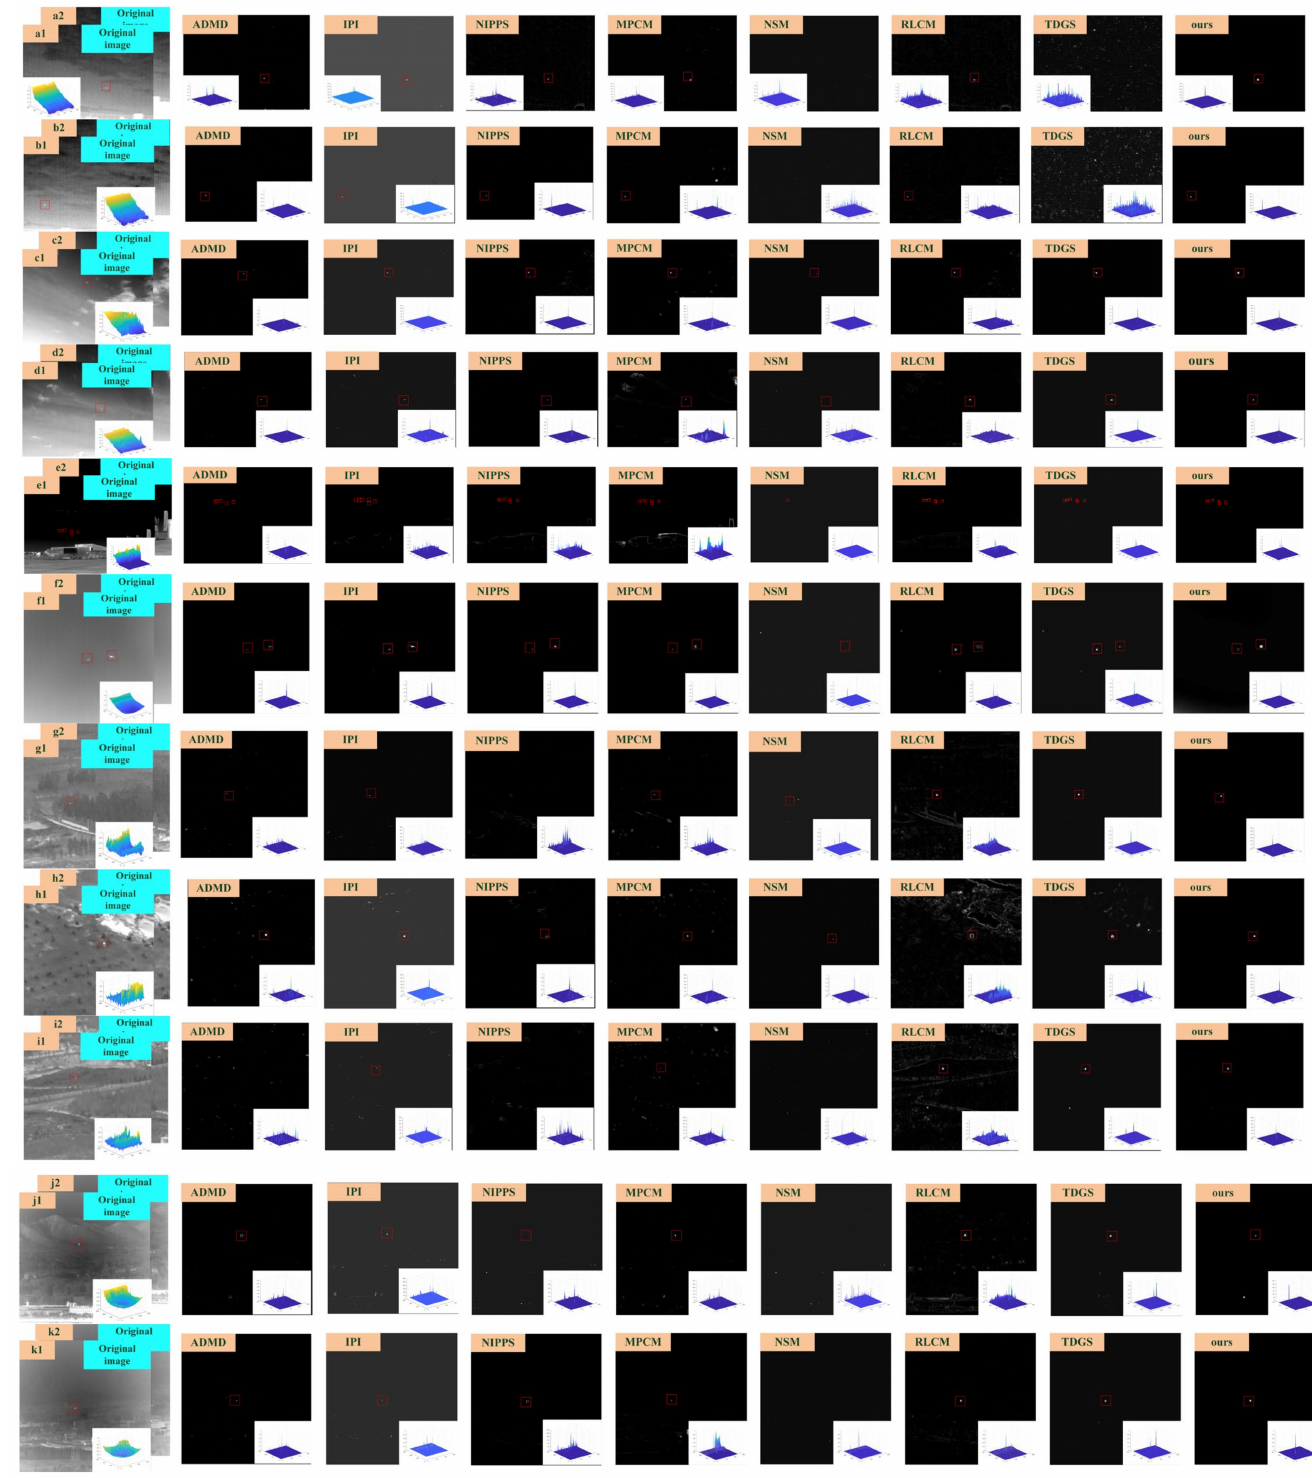
Figure 9. Target detection results. ( a – k ) in the figure is the infrared image of different targets in different backgrounds; 1,2 represents the pictures with the target motion changes in the continuous